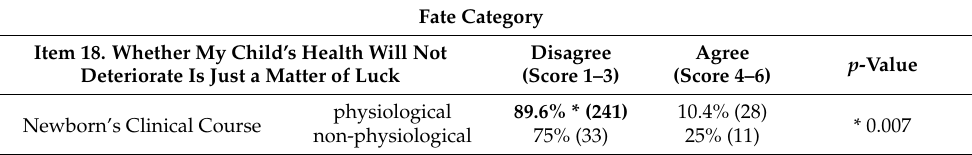
Table 6. Statistically significant correlations between “Fate” category and socio-demographic charac-